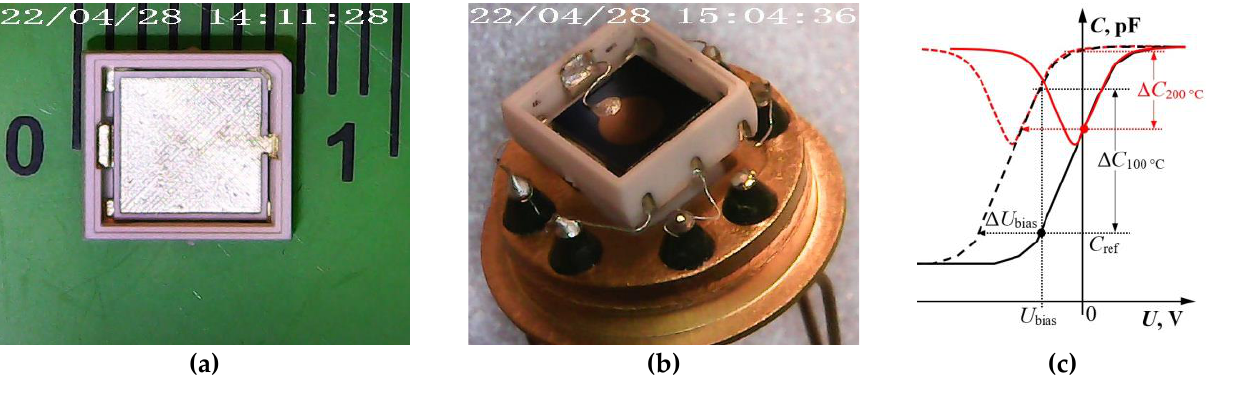
Figure 1. High-temperature ceramic package (without MOS structure) created using laser micro- milling technology with Platinum and gold metallization ( a ). An example of the MOSFEC sensors ’ high-temperature design: the standard TO-8 package is used as a base (adapter) for the monolithic sintered ceramic housing ( b ). An example of the CV characteristics ’ shift of the Si-based MOS ca- pacitor under the Hydrogen action at the operating temperature of 100 and 200 °C — black and red curves, respectively ( c ). Solid lines — CVC in the absence of H 2 , dotted lines — CVC in the presence of H 2 . See the text for a description of the designations.